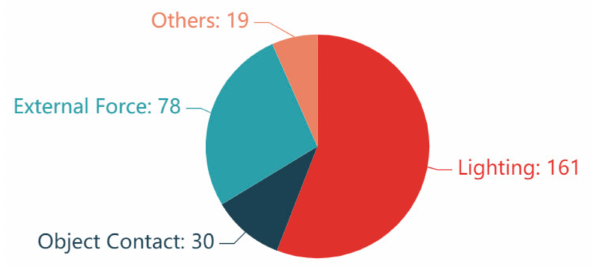
Figure 1. Distribution of transmission line fault cause after